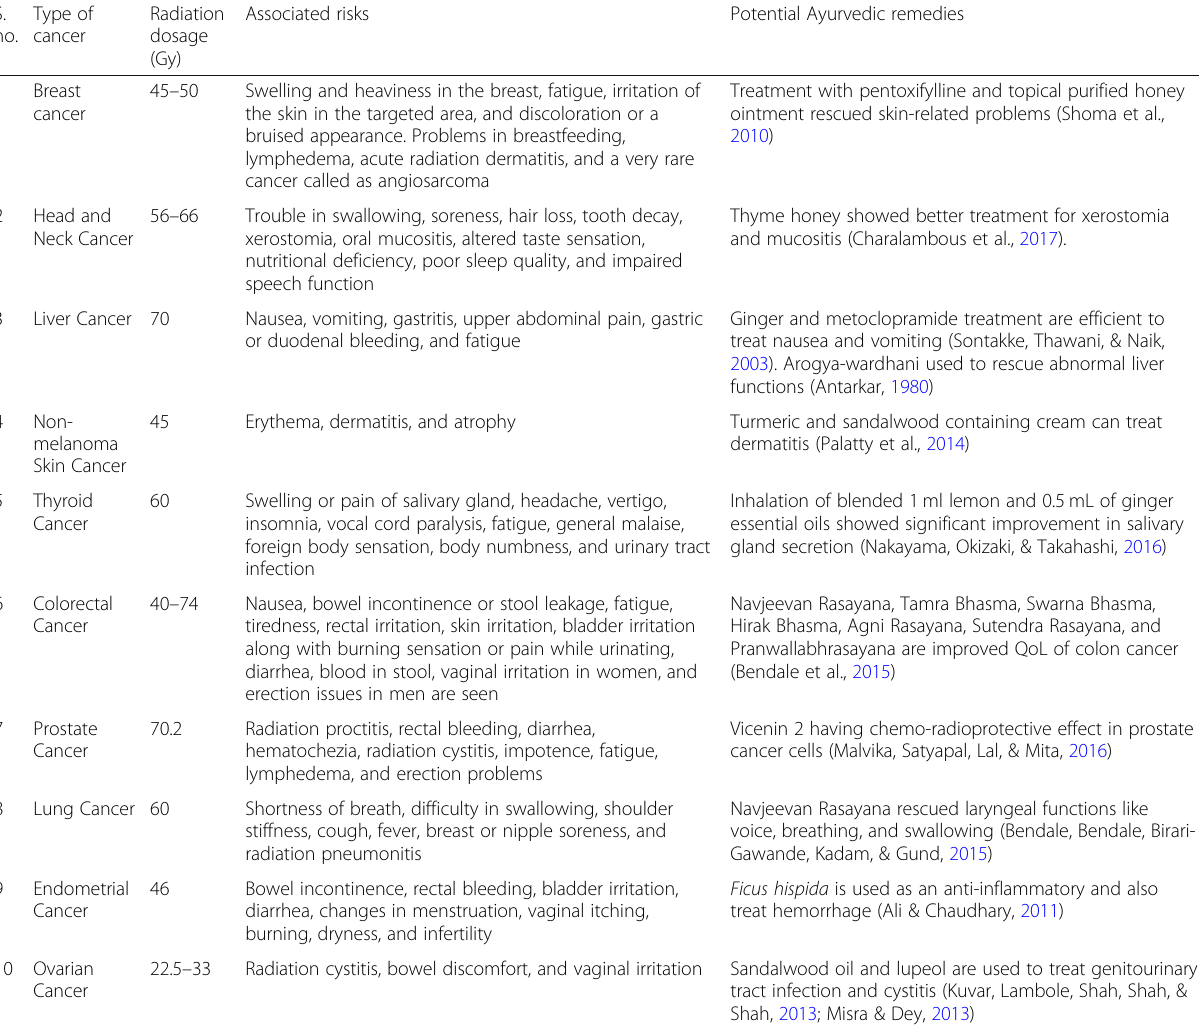
Table 1 Risk and remedies of radiation therapy in various cancers S. Type of no.